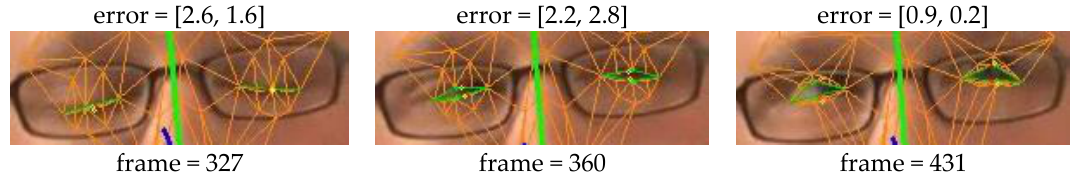
Figure 5. Eyelid distance errors for images from video ”123”. The yellow point is the ground truth, the greed point is the tracked result. The error is defined as absolute difference between the tracked eyelid distance and the ground truth. Take frame 327 for example, the left eyelid error is 2.6 pixels while the right eyelid error is 1.6 pixels. The pupil distance is 101.1 pixels for video ”123”. error = [0.5, 0.5]